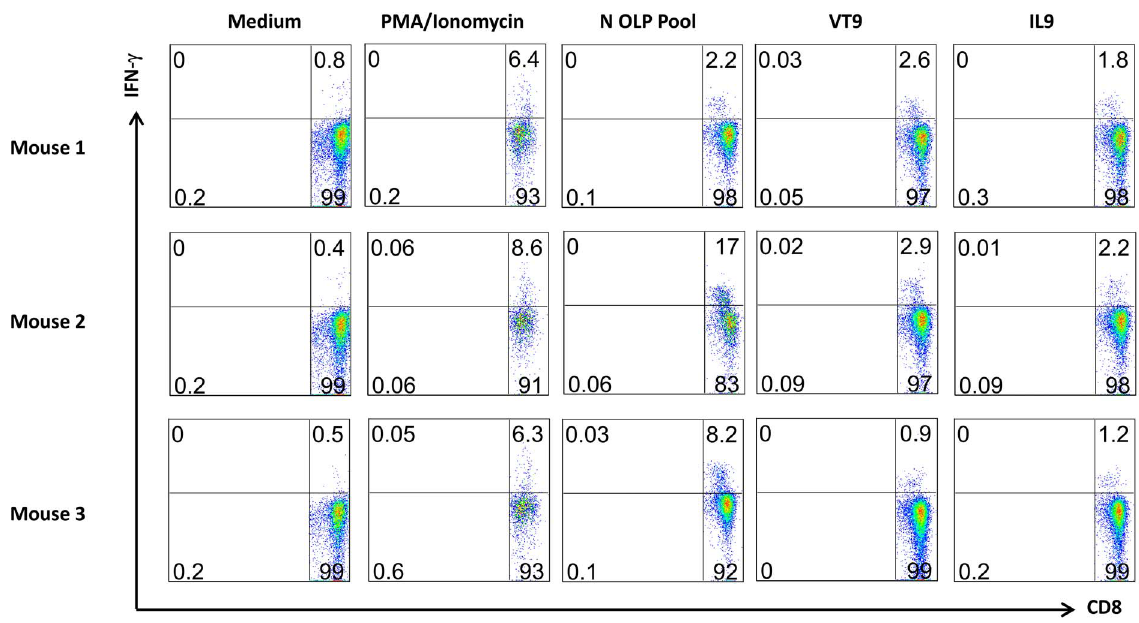
Figure 5. Robust N-specific CD8 T cells induced by the protective attenuated RVFV MP-12 vaccine in HLA-A2 transgenic mice. Mice were immunized subcutaneously with 1x10 4 pfu of MP-12 and boosted with the same dose six weeks later. Splenocytes were harvested five days later and re-stimulated with T2 cells pulsed with N-OLP peptide pool (10 m g/ml each), VT9 or IL9 peptide (10 m g/ml) for 6 hours. Splenocytes treated with PMA (10 ng/ml) and Ionomycin (1 m M) (PMA/Ion) or cultured in medium without peptide were used as positive and negative controls, respectively. N-specific CD8 + T cell responses were assessed by the secretion of intracellular IFN c .